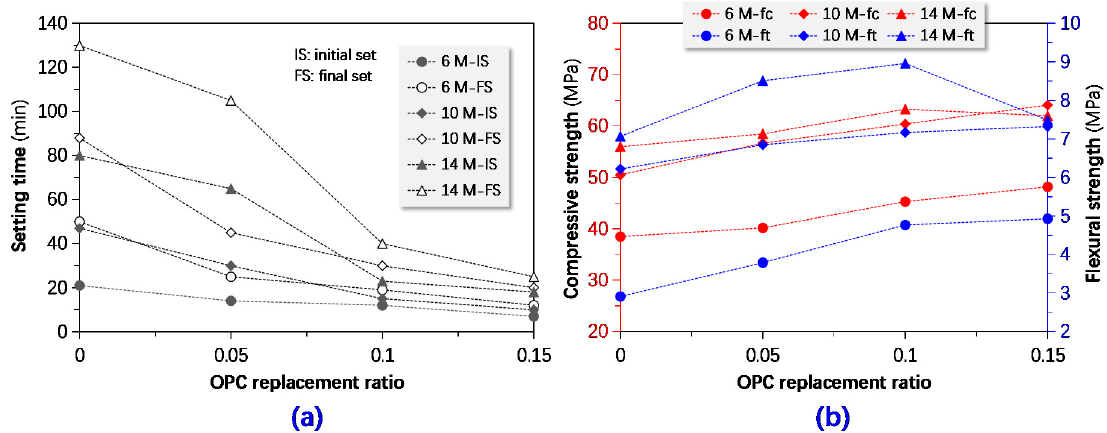
Figure 13. Influences of ordinary Portland cement (OPC) replacement ratio (by mass) on ( a ) setting time and ( b ) compressive and flexural strength.